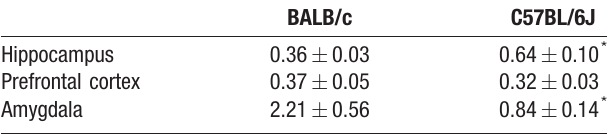
Table 2. GR protein expression corrected for total protein (gray values mean (cid:3) SEM) in hippocampus, prefrontal cortex, and amygdala of BALB/c and C57BL/6J